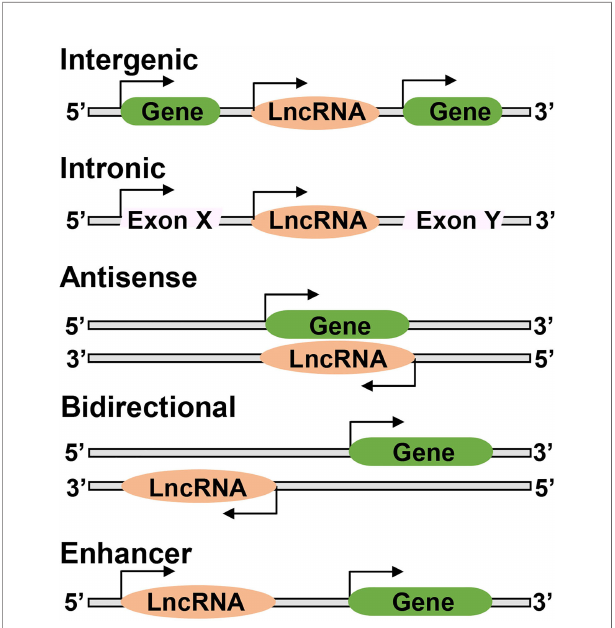
FIGURE 2 | Long noncoding RNAs may have different genomic locations; between two protein coding genes ‘ Intergenic ’ , or located within an intron of a coding gene ‘ Intronic ’ , or overlap with one or more introns and exons of a different transcript on the same or opposite strand, respectively ‘ Antisense ’ , or be within 100 kb of a coding transcript of the opposite strand ‘ Bidirectional ’ , or present in the enhancer regions close to the promoter ‘ Enhancer ’